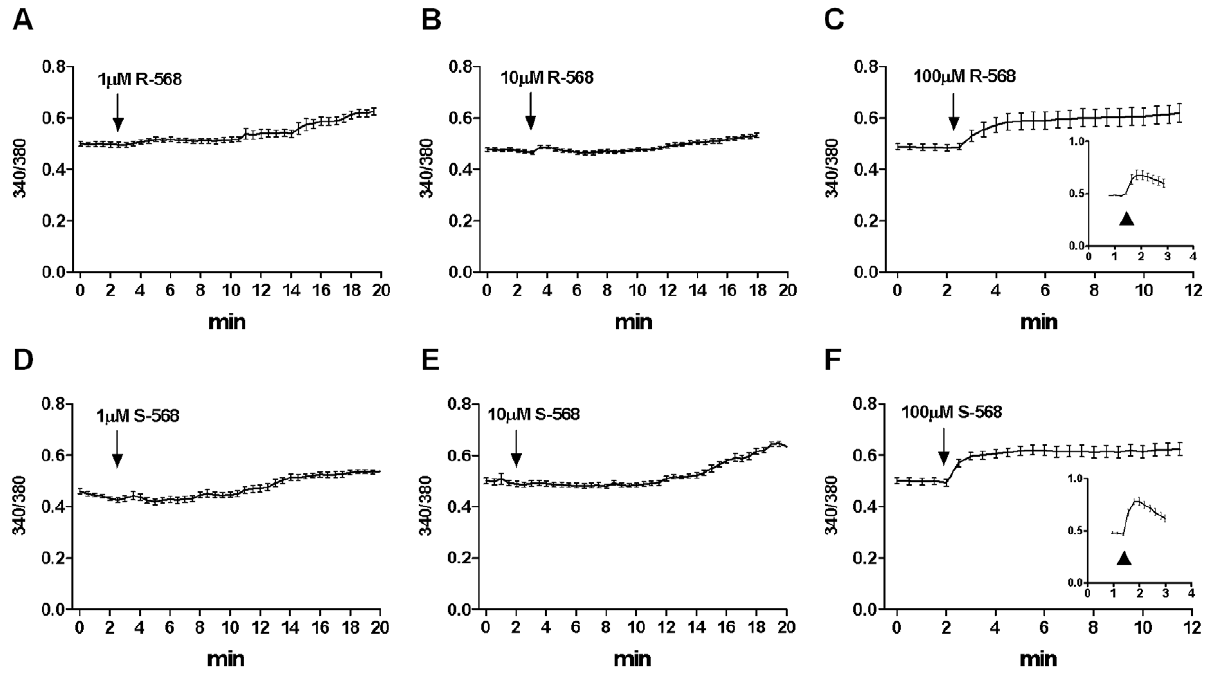
Figure 2. Effects of different doses of R-568 or S-568 on HUVECs [Ca 2 + ] i . Traces (mean value 6 SE) representing [Ca 2 + ]i variations in FURA- 2AM-loaded HUVECs stimulated with R-568 (A–C) or S-568 (D–F) at 1 m M (A and D), 10 m M (B and E) or 100 m M (C and F) concentrations. Representative traces after stimulation with R-568 100 m M + Calhex 10 m M (inset C) or S-568 100 m M + Calhex 10 m M (inset F).